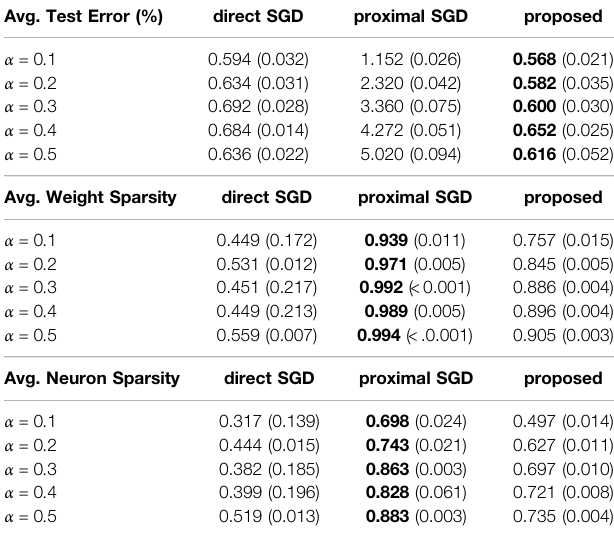
TABLE 11 | Average test error, weight sparsity, and neuron sparsity of SGL 1 -regularized Lenet-5 models trained on MNIST with lowest test errors across 5 runs. Avg. Test Error (%)